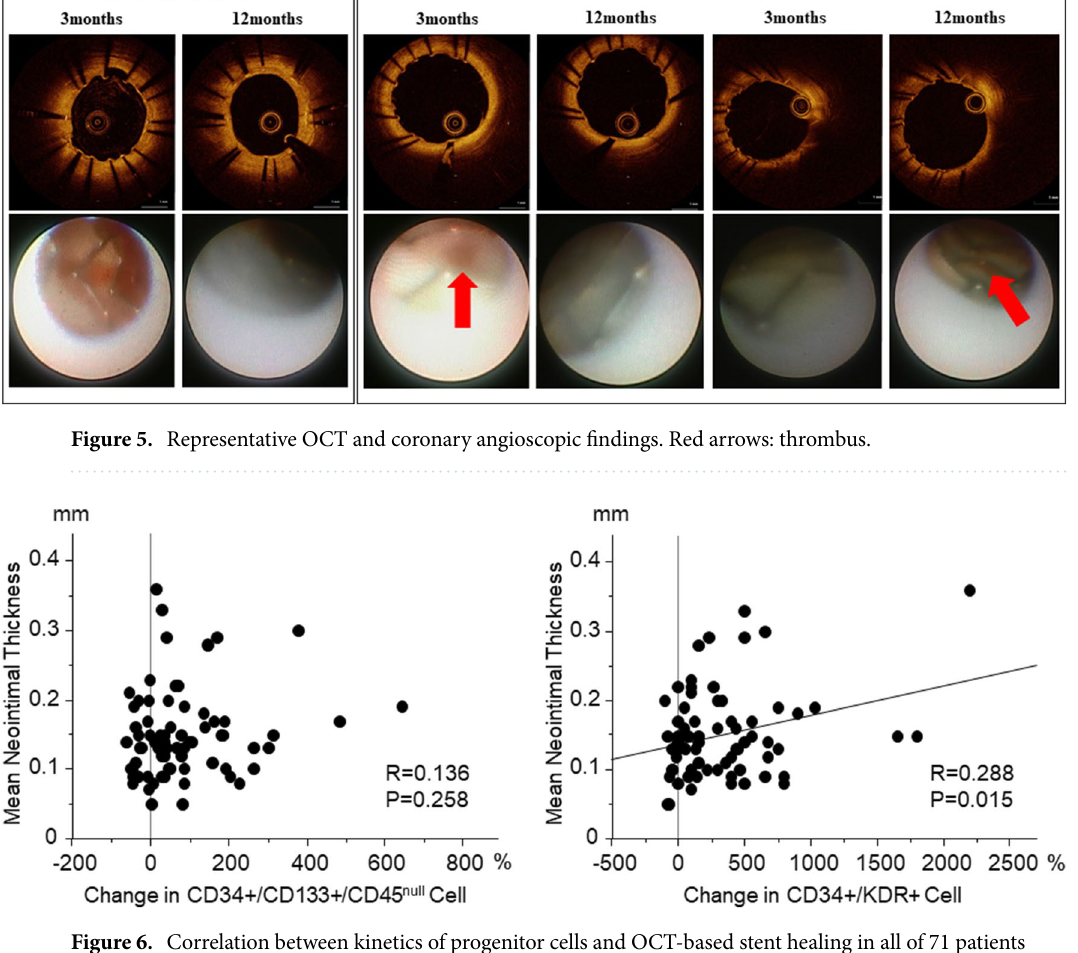
Figure 6. Correlation between kinetics of progenitor cells and OCT-based stent healing in all of 71 patients combined SYNERGY and PROMUS